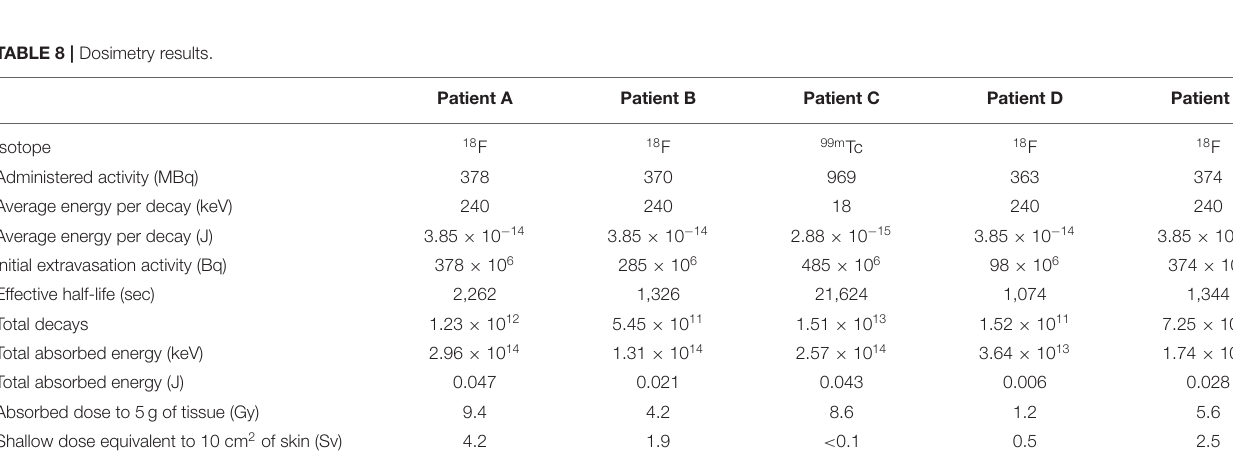
TABLE 8 | Dosimetry